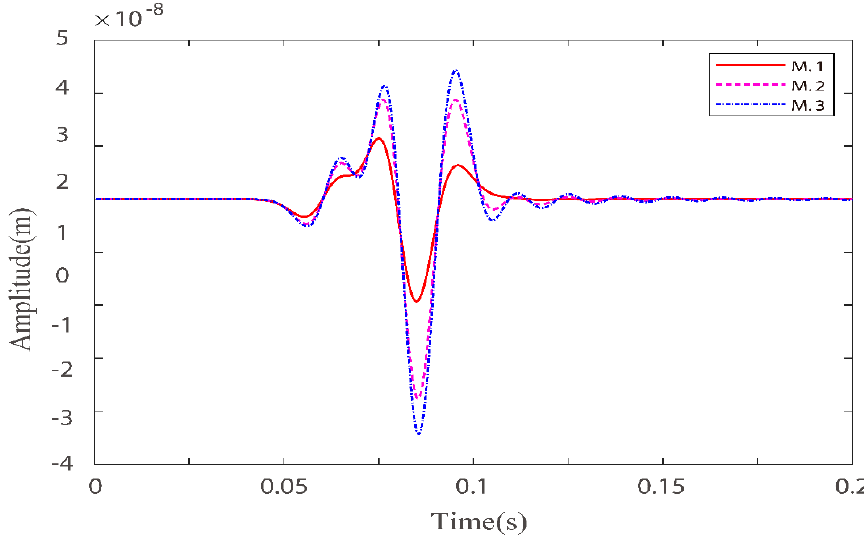
Figure 7. Comparison of solid ‐ phase z–direction velocity components with three different quality factor groups at point ( 160,160 ) .